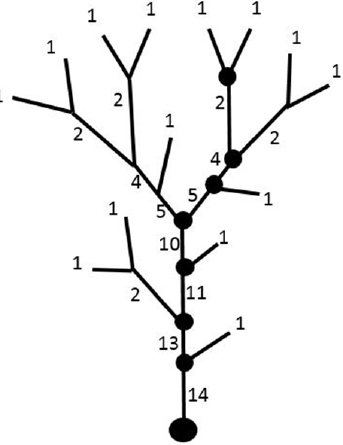
Figure 5. The Mandelbrot–Vicsek tree of magnitude 14. The mag- nitude of each link is written next to the link. One link of each mag- nitude is distinguished by the dots along the network.